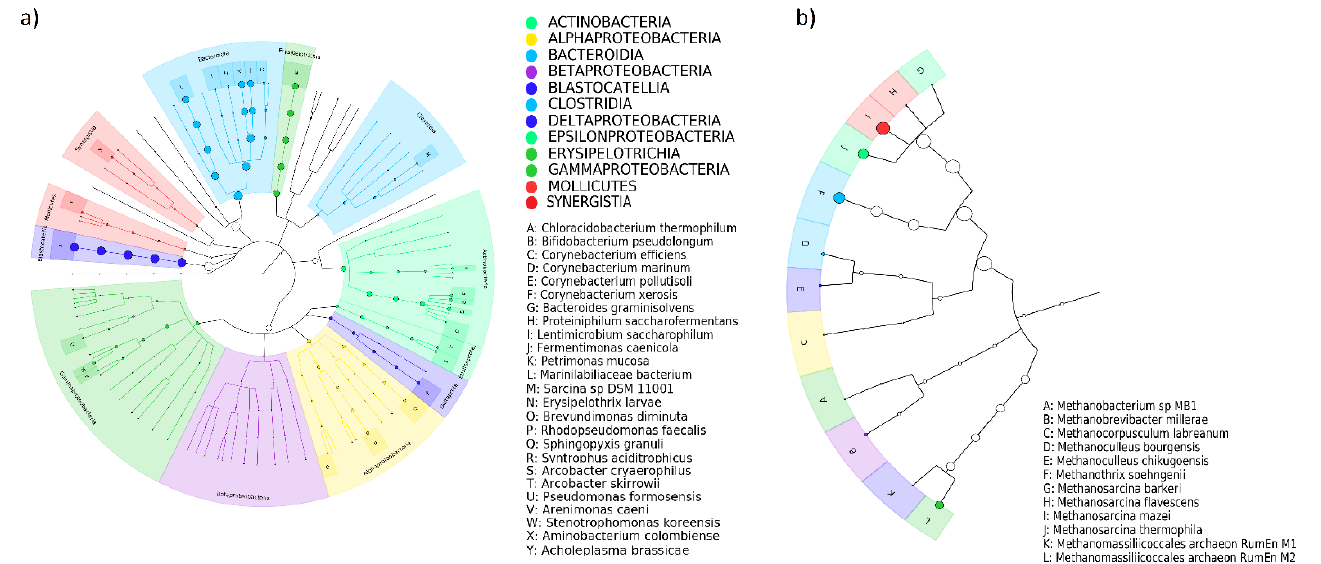
Figure 3. Circos presenting the ( a ) most abundant bacterial consortia in digestate samples and ( b ) most abundant Archaea consortia in digestate samples. The OTU values of the presented species exceeded 1 ppm.